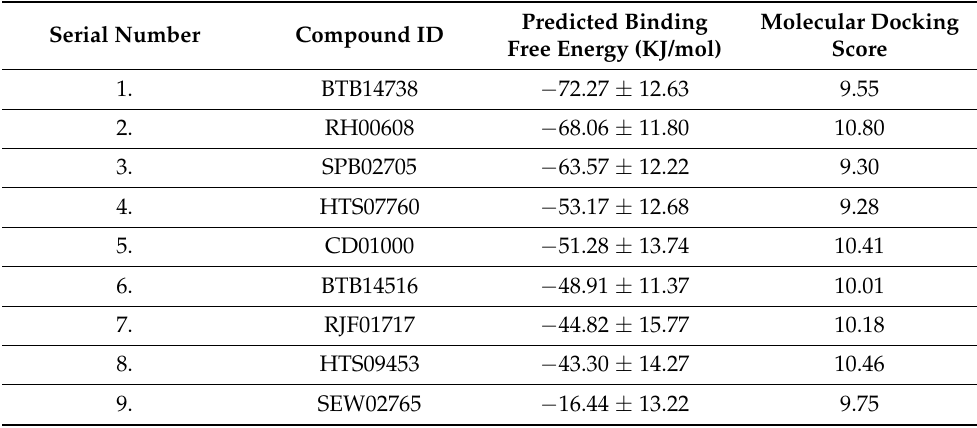
Table 2. The predicted binding free energy and molecular docking score for selected protein-ligand complexes is